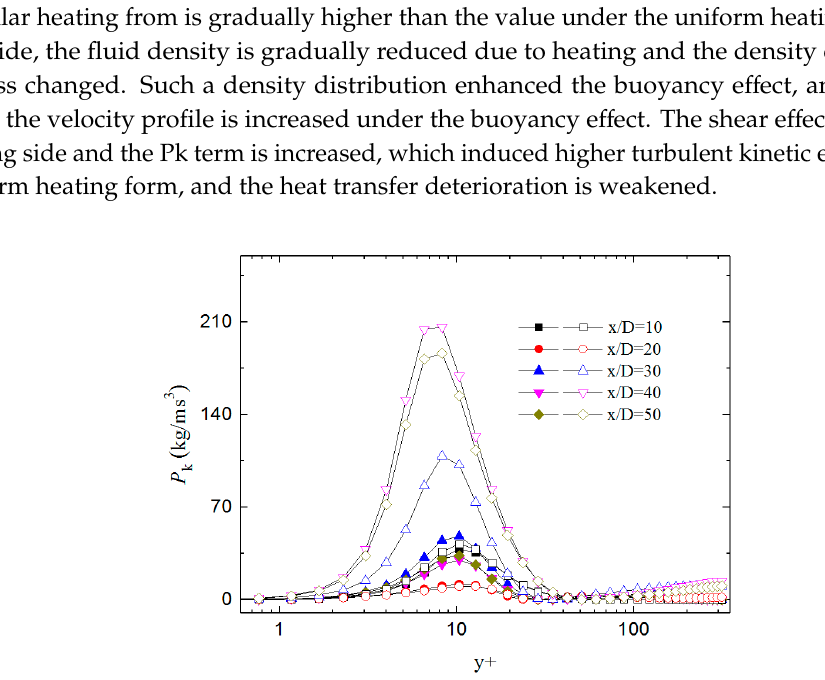
Figure 12. Shear stress production of turbulent kinetic energy in different location (Solid: C2; Hollow: D2).